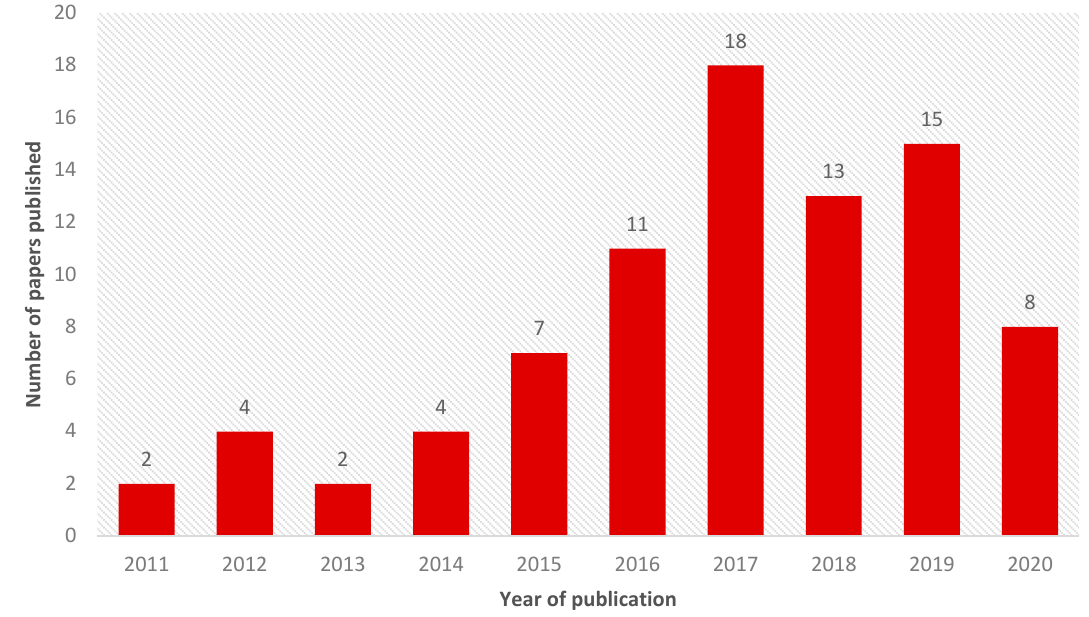
Figure 2. Number of scientific reports on the use of silver nanoparticles in dentistry by year, focusing on the last decade (2010–2020).